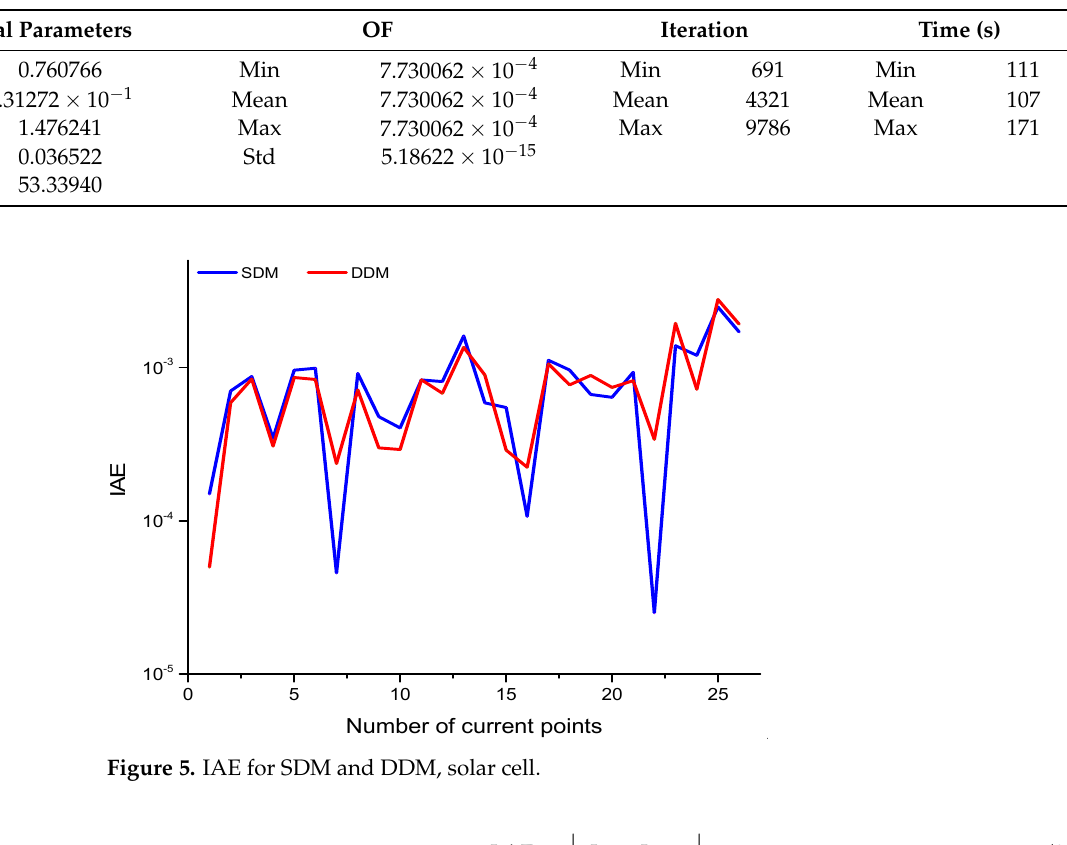
Figure 6. I–V curve for experimental and computed current values of SDM, solar cell.